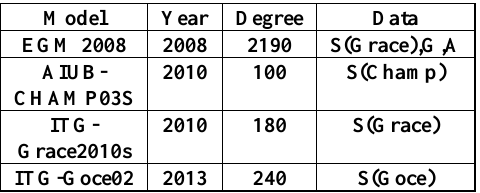
Table 1. The list of GGMs for